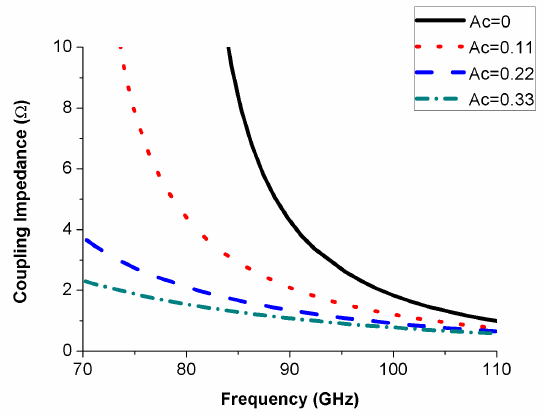
Figure 4. Coupling impedance of the CV-FWG for various values of Ac.